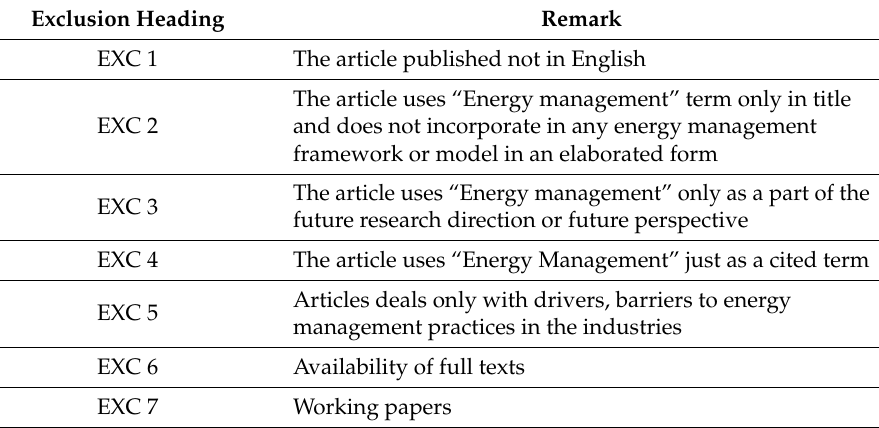
Table 2. Exclusion criterion of the